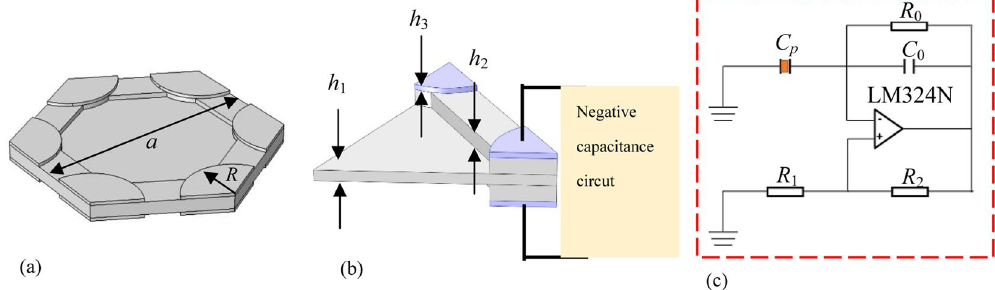
Figure 1. ( a ) A unit cell bonded by piezoelectric patches, ( b ) the piezoelectric patches attached by the negative capacitance circuits and ( c ) the negative capacitance circuit.